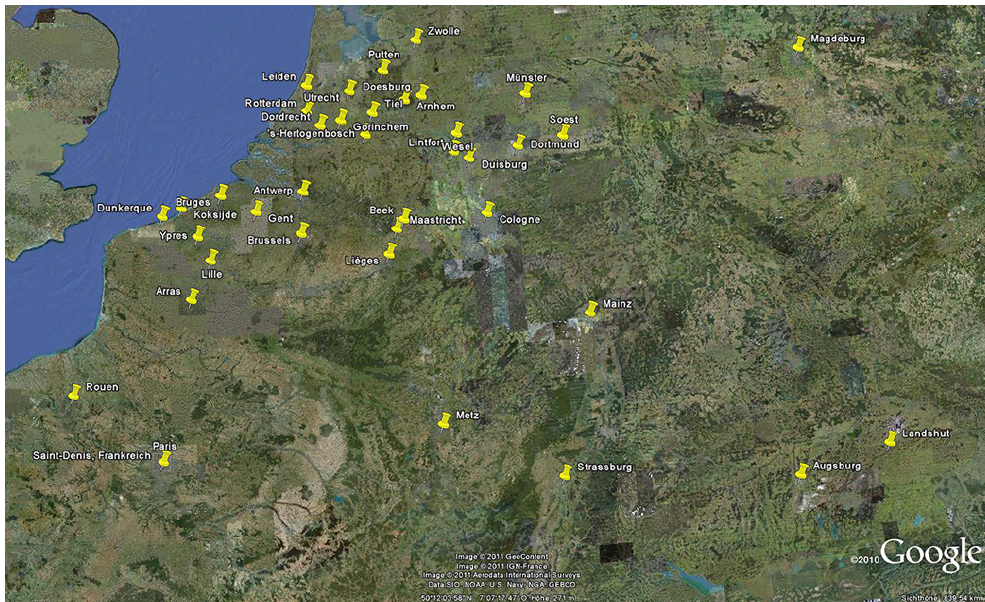
Figure 3. Geographical distribution of the origin of the sources.